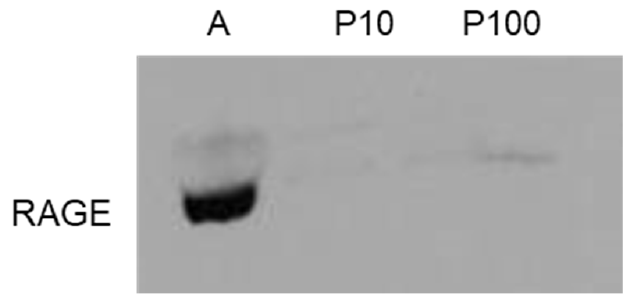
Figure 4. Protein level of the Receptor for Advanced Glycation End Products (RAGE) in HASC-P10 and HASC-P100 EVs, evaluated by Western blot. A: Positive control (human primary osteoblasts, PromoCell (Heidelberg, Germany) [34]).